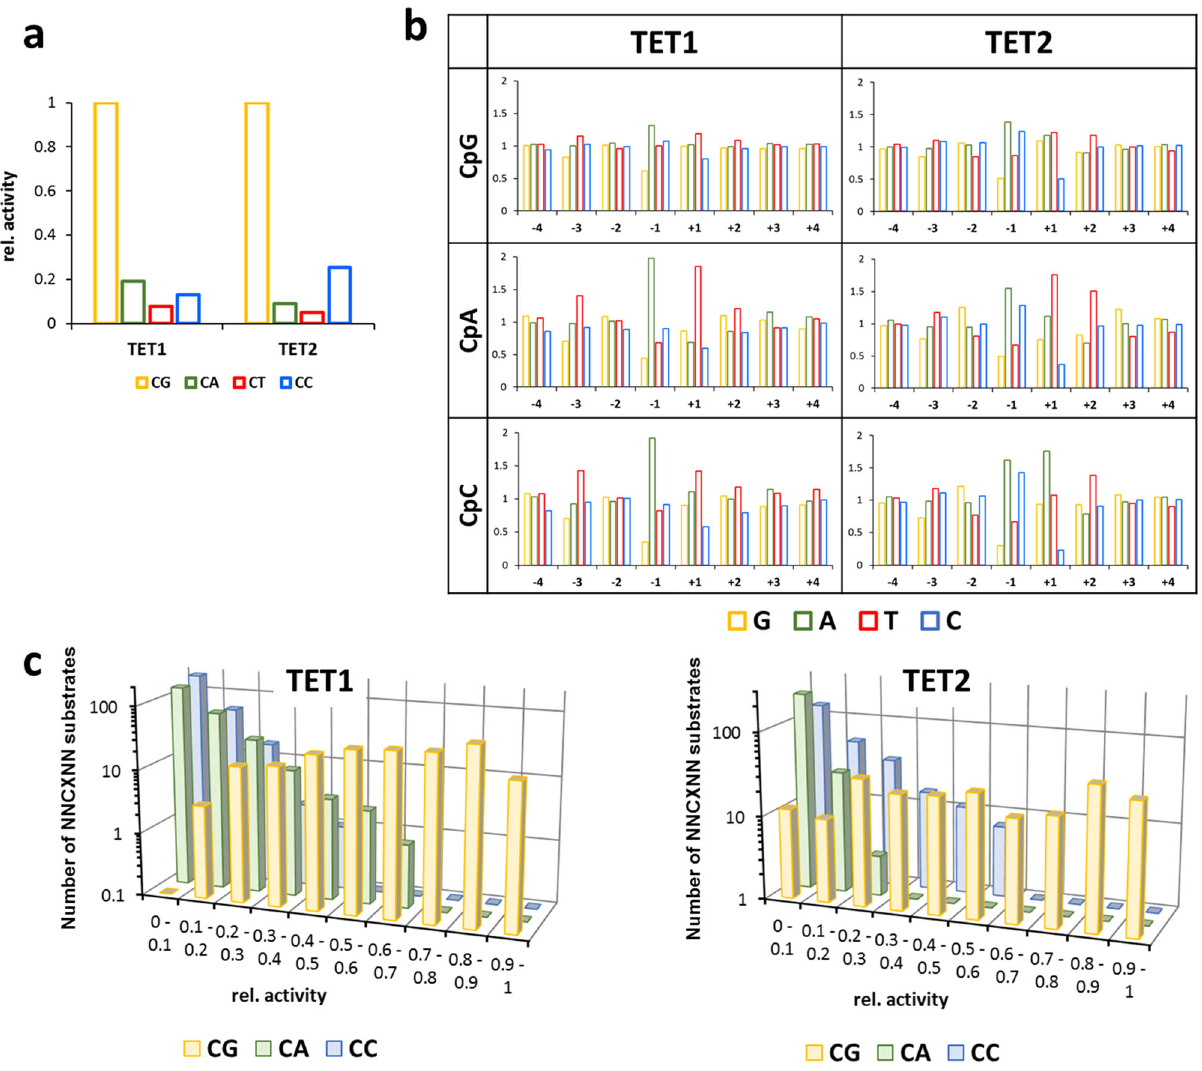
Fig. 4 Flanking sequence effects on the oxidation of mCpX substrates by TET1 and TET2. a Relative oxidation of different CpX (X = G, A, T, or C) substrates. b Average oxidation levels of mCpX substrates containing speci fi c bases at − 4 to + 4 fl ank positions. Oxidation levels are given as observed/ expected values. c Frequency of NNCXNN substrates within de fi ned ranges of relative activities showing the overlap of activity ranges of preferred non- CpG and disfavored CpG